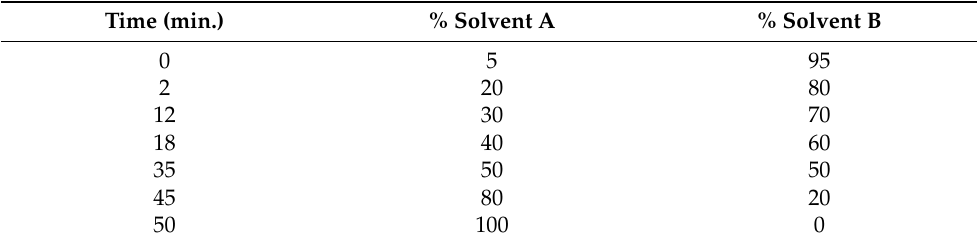
Table 6. HPLC Gradient elution profile. Time